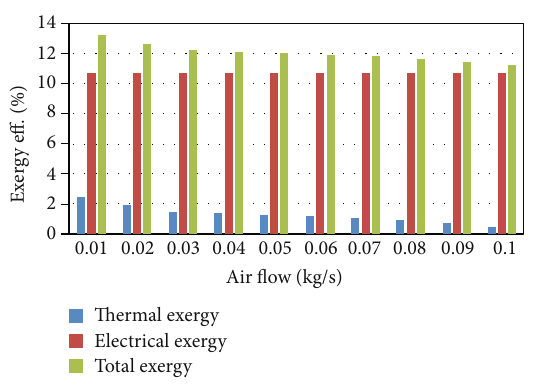
Figure 4: The e ff ect of air fl ow change on exergy e ffi